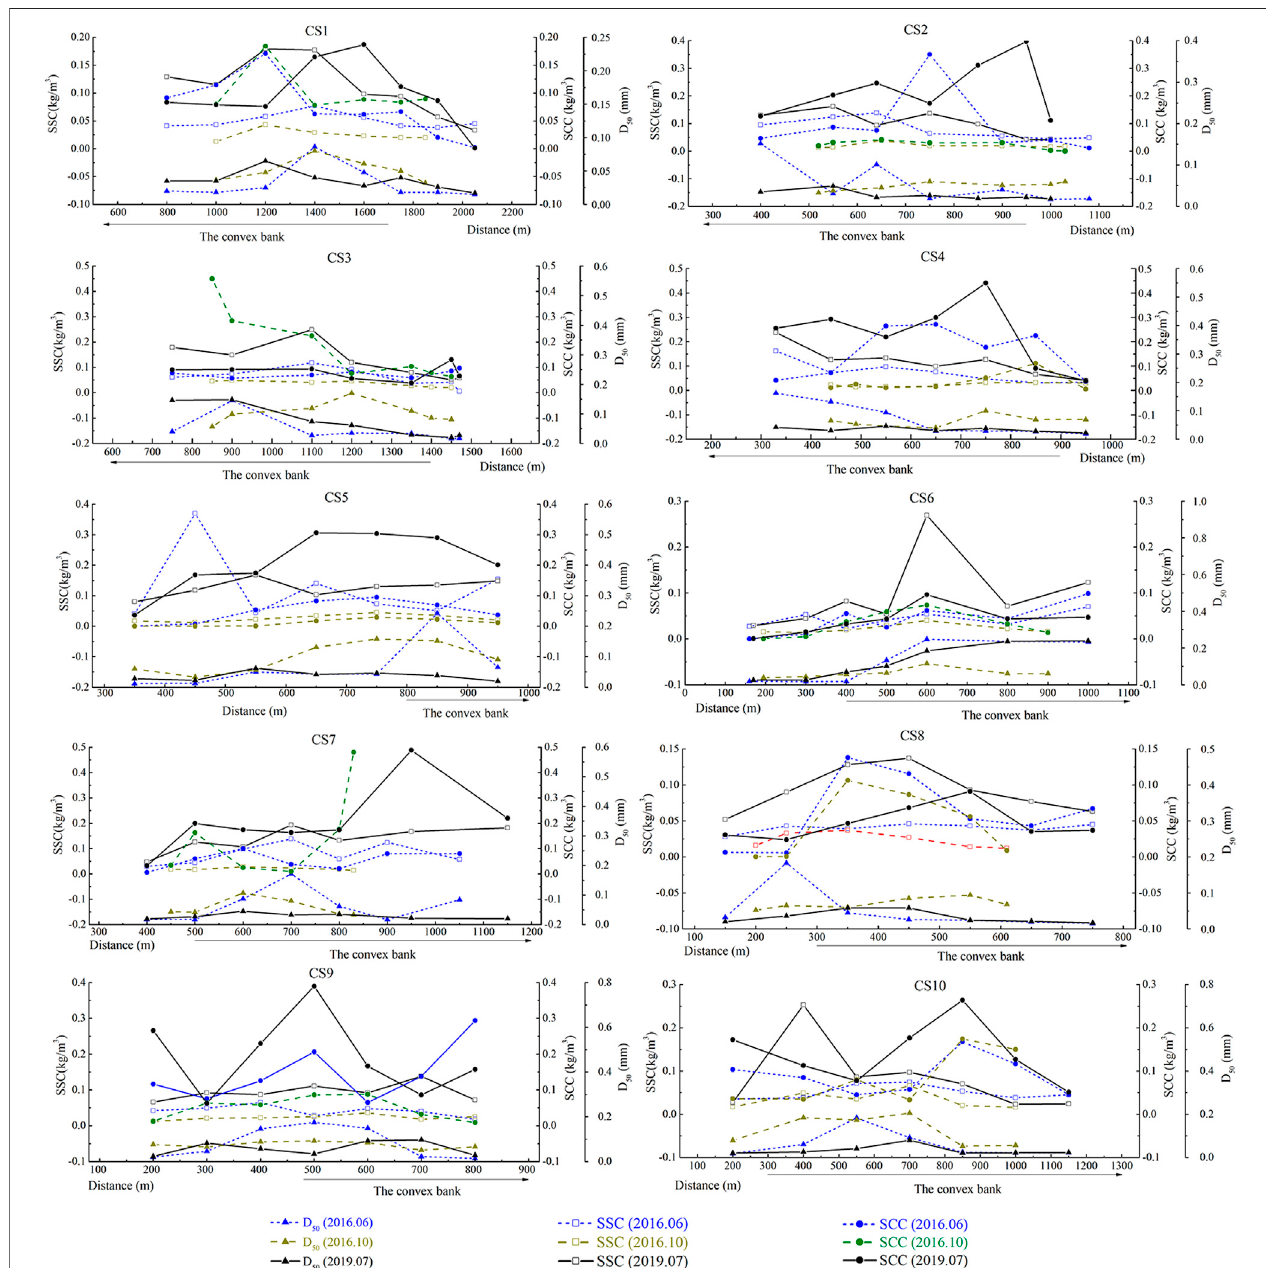
FIGURE8| Variationsofsedimentcarryingcapacity(SCC), suspended sedimentconcentration(SSC),and suspendedsedimentmediangrainsize(D 50 )inBendA and Bend B during different discharges.